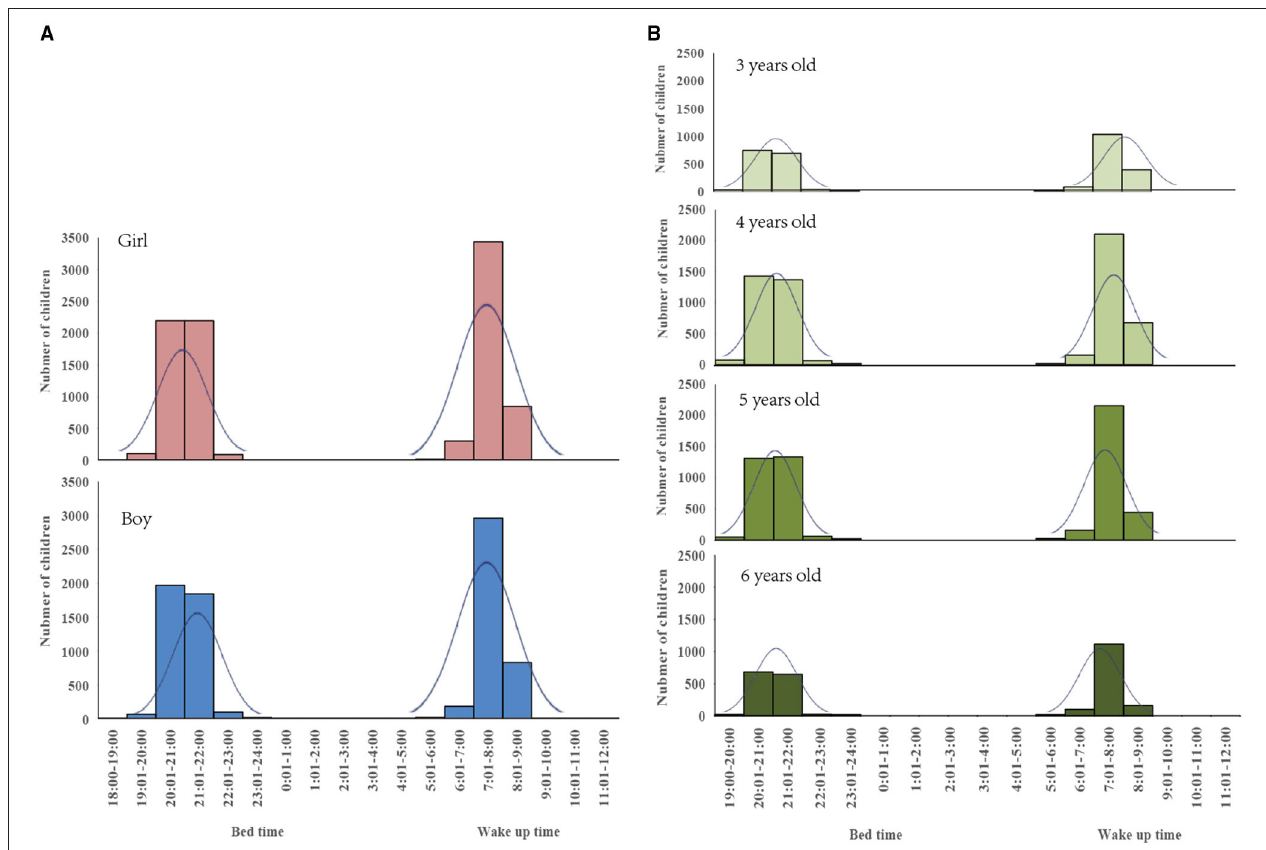
FIGURE 1 | The frequency distribution of the bedtime and wake-up time of children between boys and girls and between children aged 3, 4, 5, and 6 years in the year 2018 in Shanghai, China. (A) Bedtime and Wake up time for children with different sex. (B) Bedtime and Wake up time for children with different